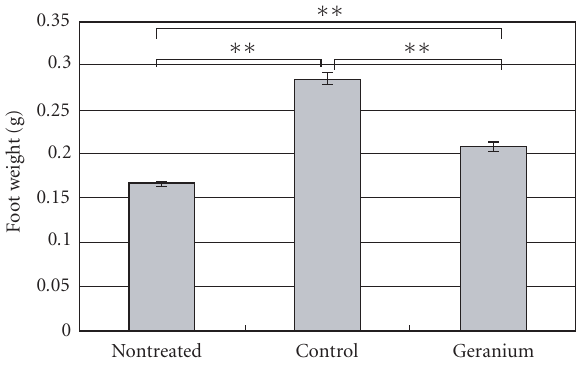
Figure 3: E ff ects of intraperitoneal administration of geranium oil on foot swelling estimated by their weight. Carrageenan was in- jected to left footpad of mice, and 10 minutes after the injection, geranium oil or DMSO was given intraperitoneaouly. Twenty four hours later, their feet were resected to measure their weight. Each value represents an average from 5 mice and the standard error. ∗∗ P < . 01 di ff erence from